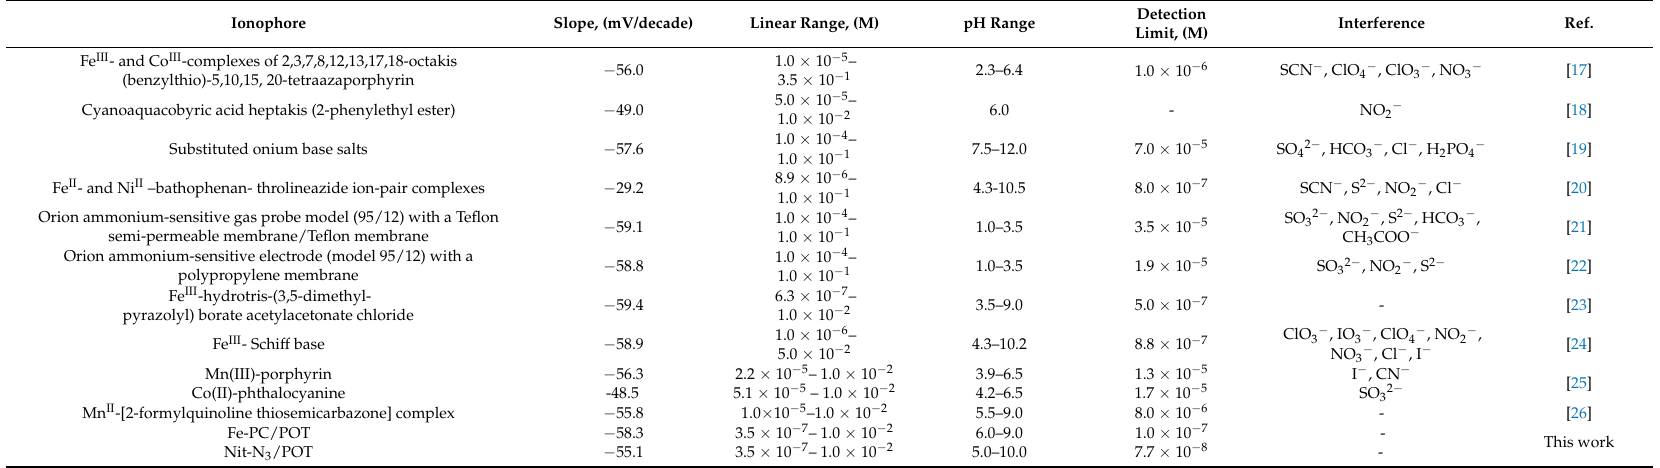
Table 2. General features of some potentiometric azide membrane sensors based on different